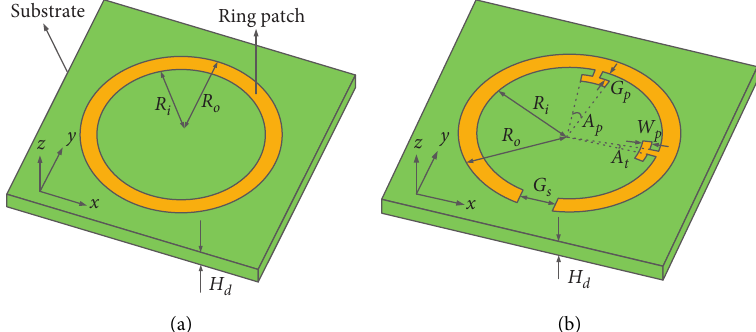
� 12, R � 10, H � 1.6, G � 4, A � 20 ° , o i d s p